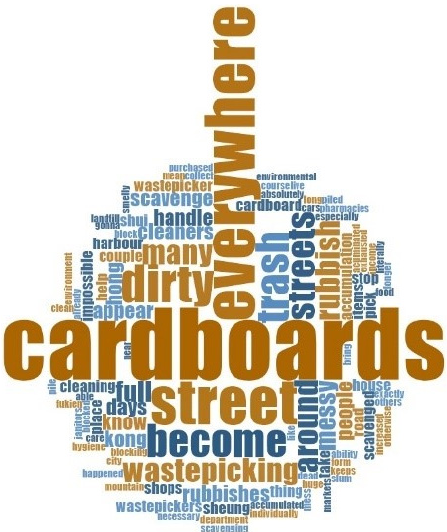
Figure 2. “Without the Older Adult IWPs, Hong Kong would be…” (older adult IWPs’ responses).